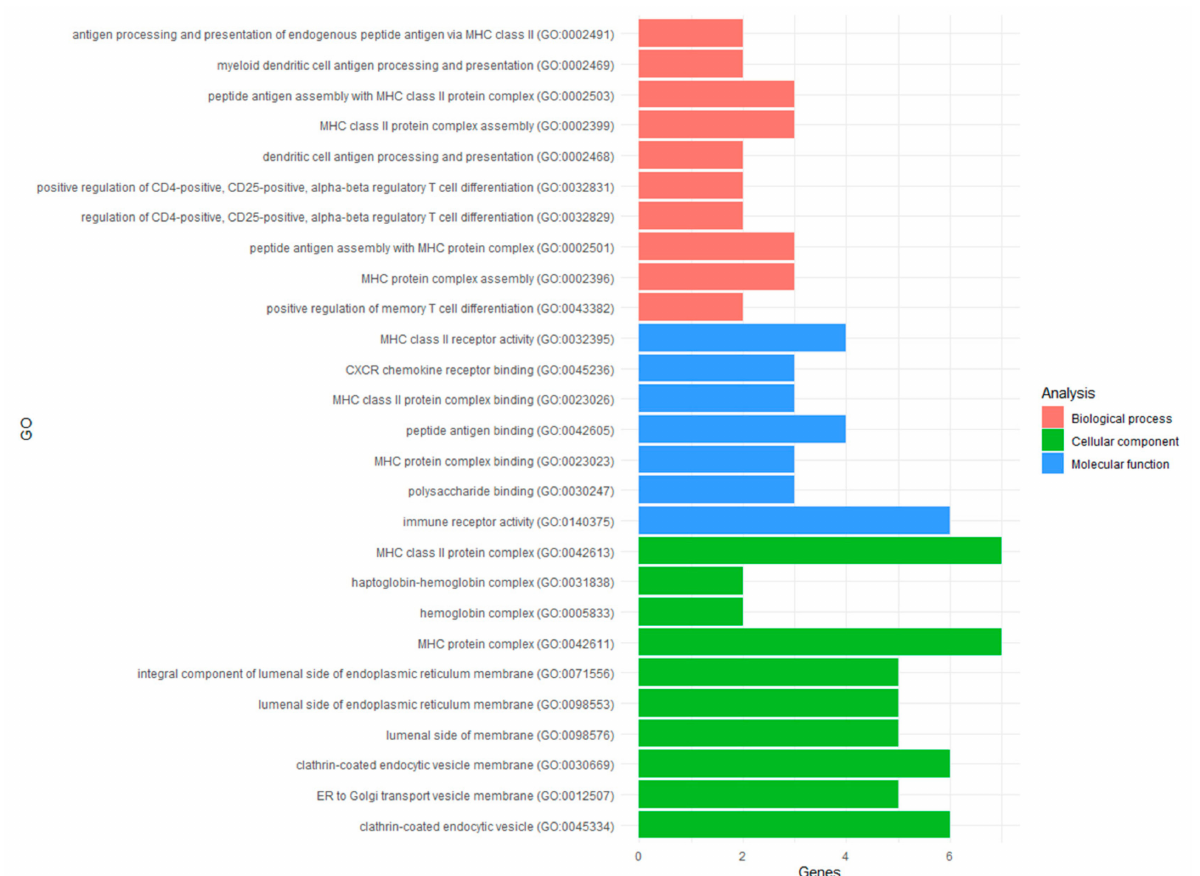
Figure 2. Results of the functional enrichment analyses of the DEGs identified in recGBM. Top ten GO terms for biological processes (red), molecular function (blue), and cellular components (green) are presented, including the number of genes overrepresented for each